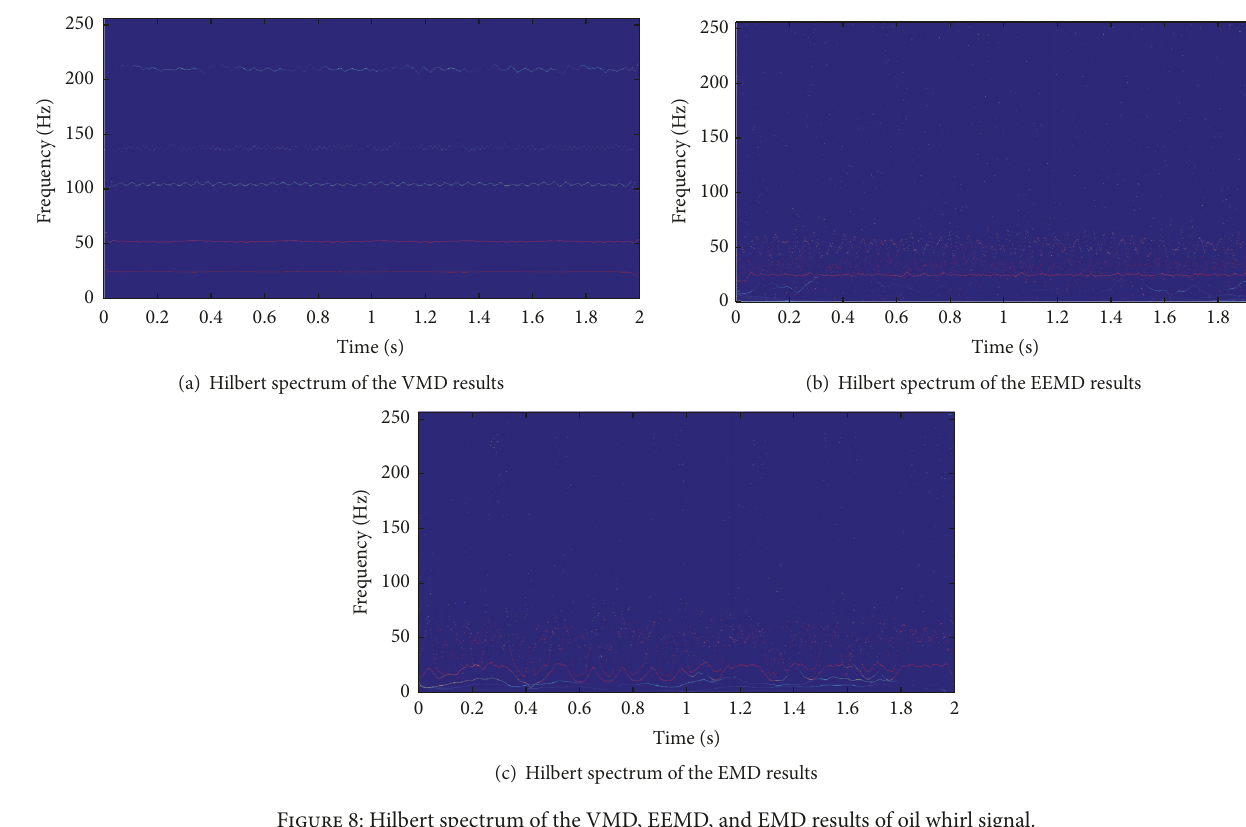
Figure 8: Hilbert spectrum of the VMD, EEMD, and EMD results of oil whirl signal.